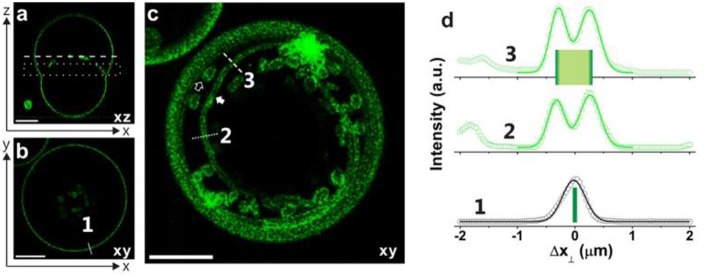
Necklace-cylinder tube coexistence for giant vesicles with Lo membranes: (a) confocal xz-scan; (b) confocal xy-scan corresponding to the dashed line in panel a; (c) superposition of 6 confocal xy-scans located in the dotted rectangle in panel a. This projection image reveals the coexistence of several long cylindrical tubes and several short necklace-like tubes. All scale bars are 10 μm. (d) Fluorescent intensity along the solid white line 1 in panel (b) perpendicular to the GUV contour and along the dotted and dashed white lines 2 and 3 in panel (c) across a cylindrical tube. The quantity Δx⊥ is the coordinate perpendicular to the GUV contour or membrane tube. The intensity profiles can be well-fitted by Gaussian distributions with a half-peak width of 0.35 ± 0.05 μm. The peak-to-peak separations for the lines 2 and 3 lead to the estimated tube diameters 2Rcy = 0.58 and 0.54 μm, respectively. Reprinted with permission from Liu et al. (2016). Copyright (2016) American Chemical Society.